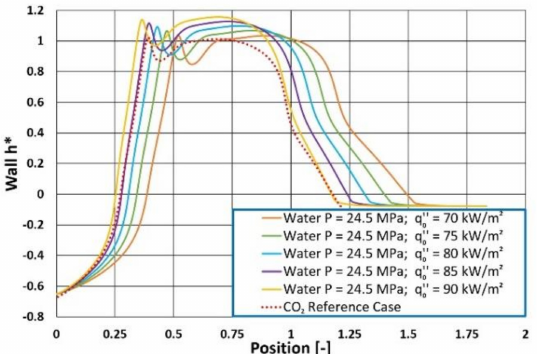
Figure 16. Wall h * trends for water at 24.50 MPa as a function of the axial position for a reference case with CO 2 , q 0 (cid:48)(cid:48) = 20 kW/m 2 and T in = 24 ◦